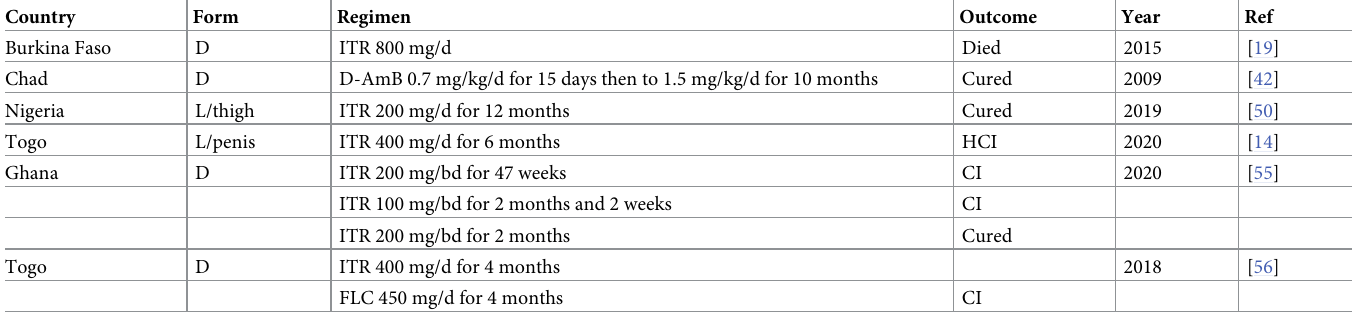
Table 3. AU : PleasecheckifTable 3 ispresentedcorrectly : Some recent clinical experience with antifungal therapy in African histoplasmosis. Country